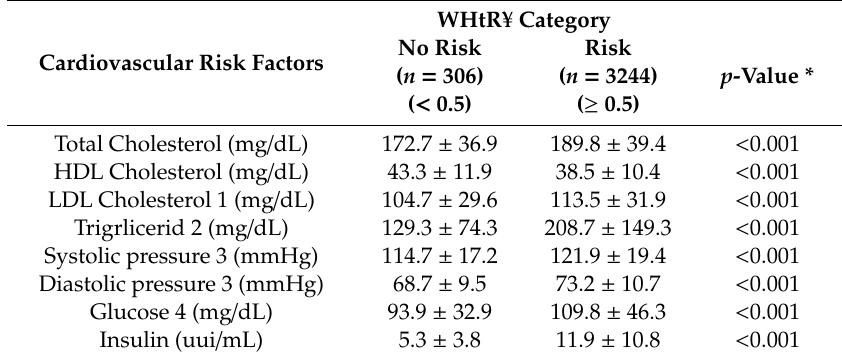
Table 2. Lipid profile, blood pressure and insulin resistance in adults 20 years and older by category of ICE, ENSANUT MC 2016. Mexico,